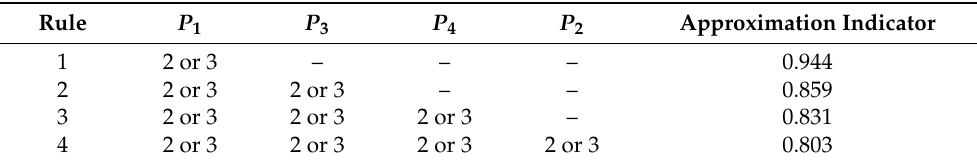
Table 3. GDRCs allowing to classify CP as ‘Accept CP for implementation’, when using the purely risky assessment strategy.